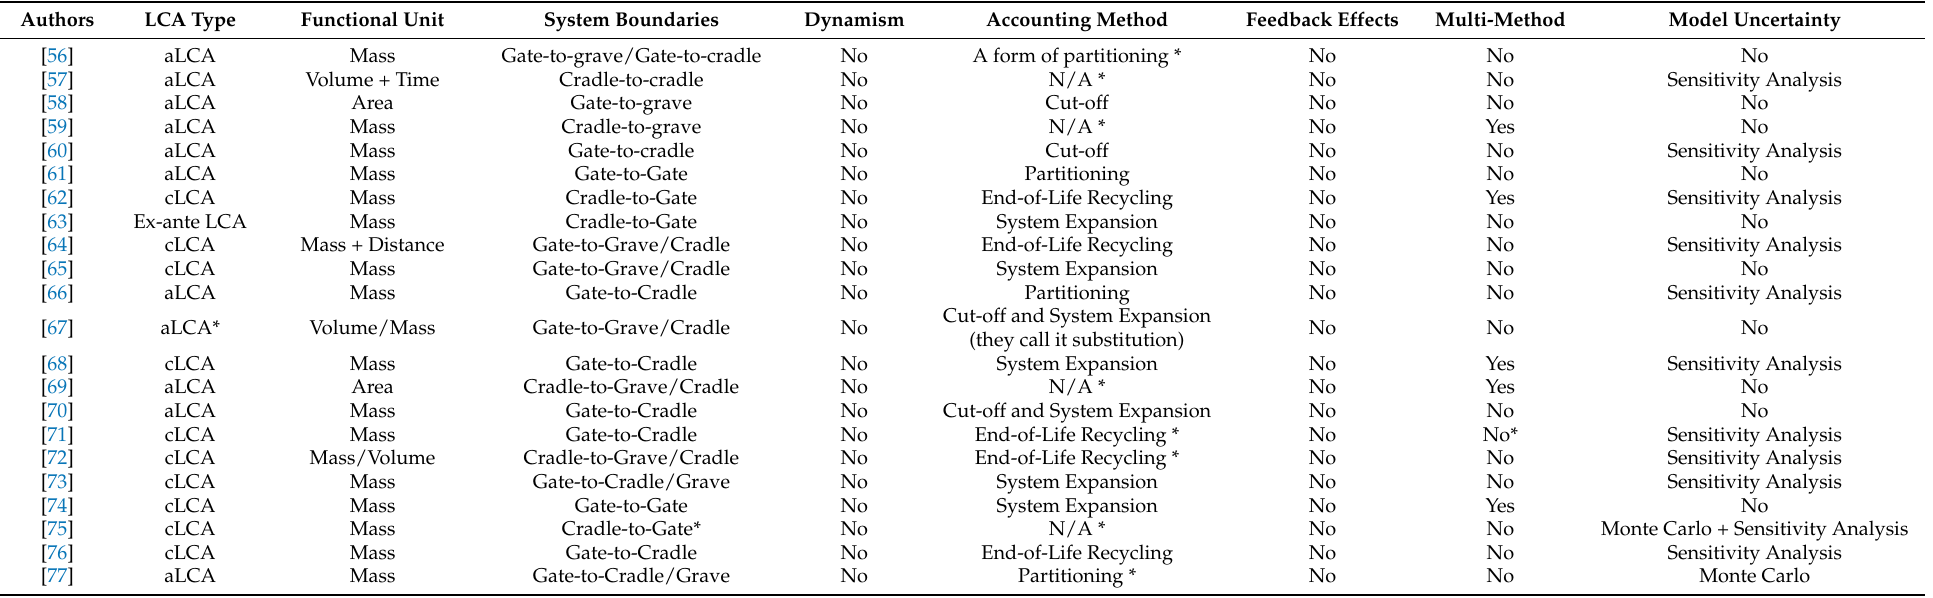
Table 2. Overview of recent papers covering end-of-life (EoL)/recycling of plastics from 2015–2020 in terms of methodological choices. aLCA: attributional LCA; cLCA: consequential LCA.